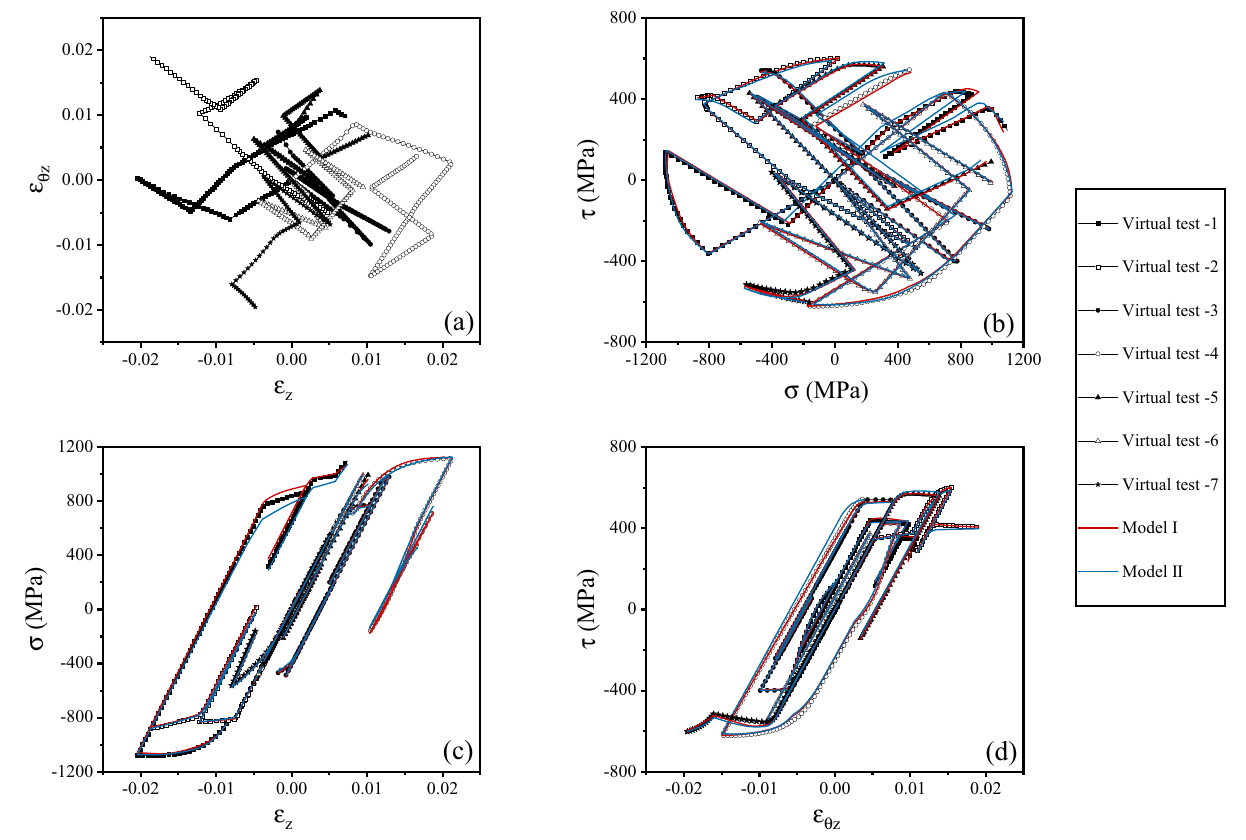
Figure 8. ( a ) Strain histories corresponding to seven random simulations used to assess the surrogate models; ( b ) stress history corresponding to the strain history in ( a ), including the predictions of the surrogate models; ( c ) normal stress versus strain history and predictions of the surrogate models; ( d ) shear stress versus strain history and predictions of the surrogate